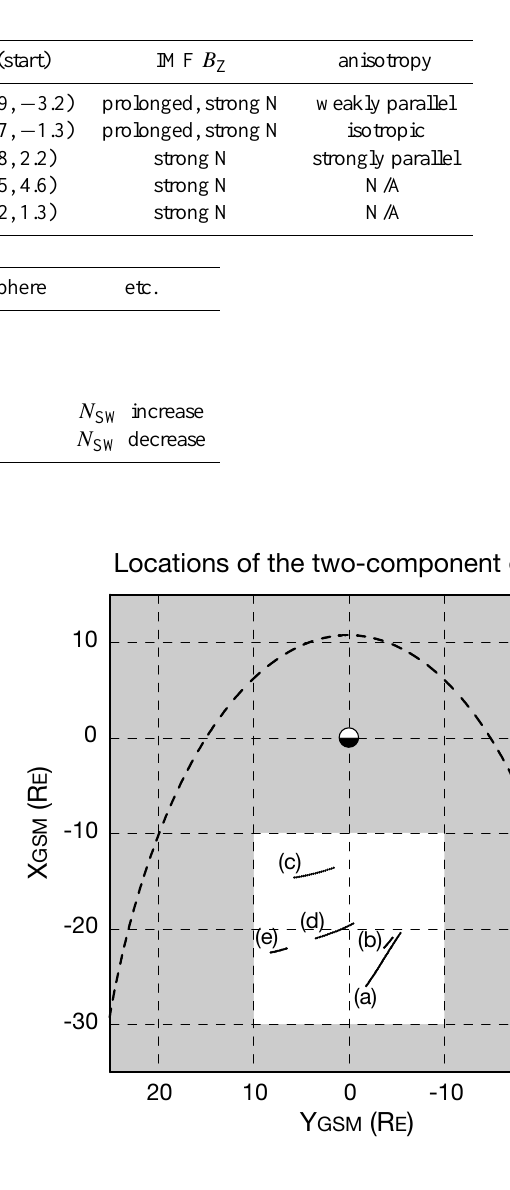
Fig. 10. Observed locations of the two-component proton events in the midnight plasma sheet. Projection onto the GSM- XY plane is shown. A dotted curve in the figure shows the averaged location of the magnetopause calculated with a model by Roelof and Sibeck